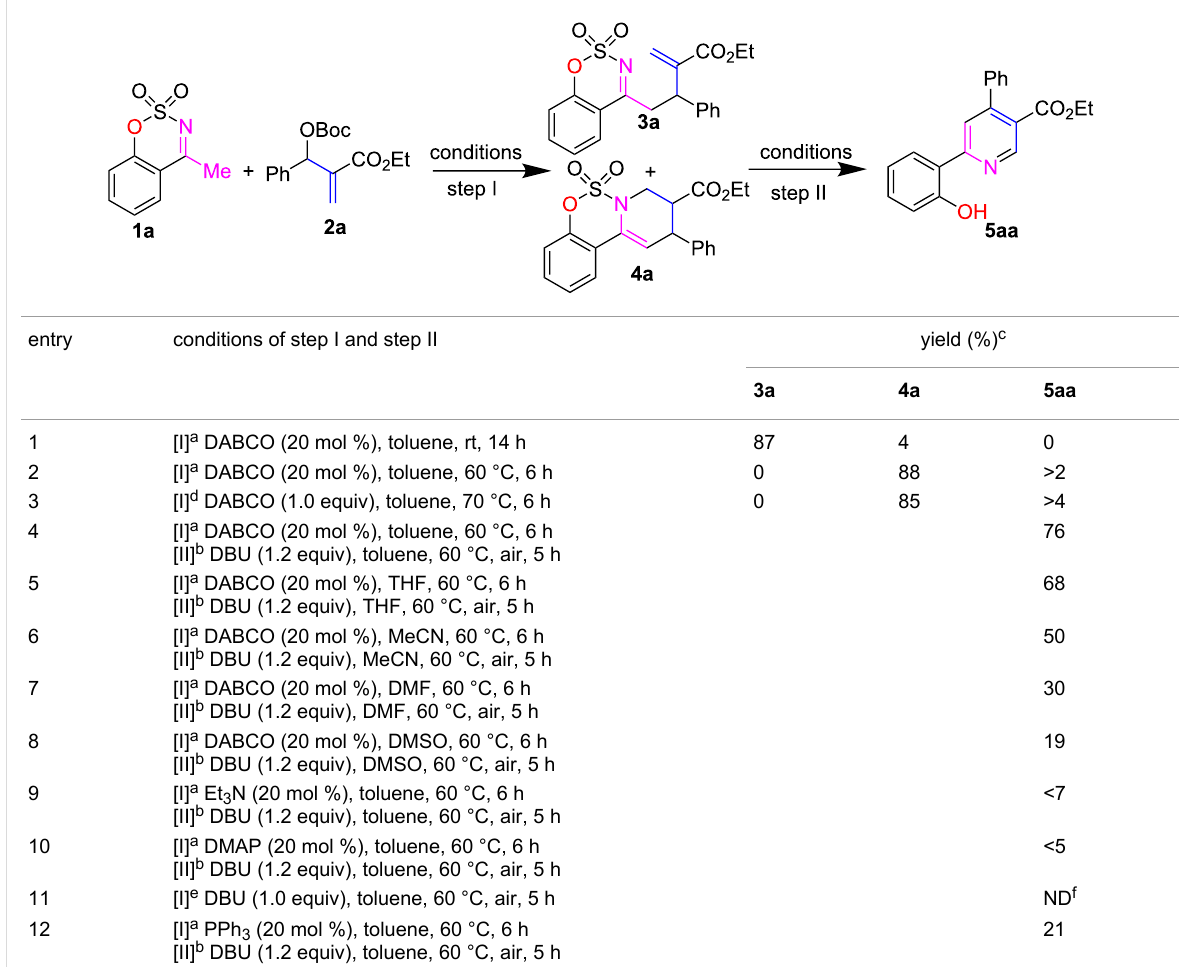
Table 1: Optimization reaction